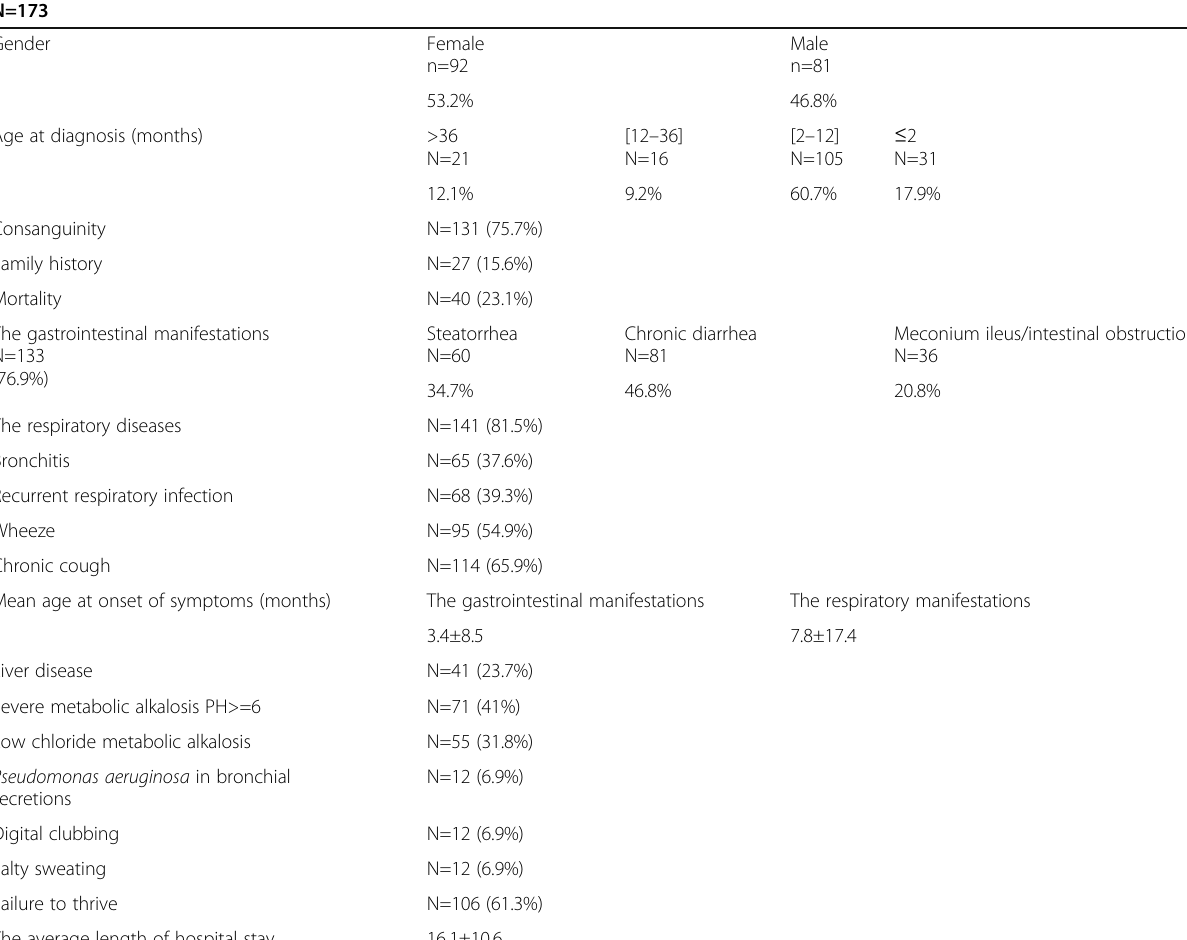
Table 3 The demographic and clinical data of the studied